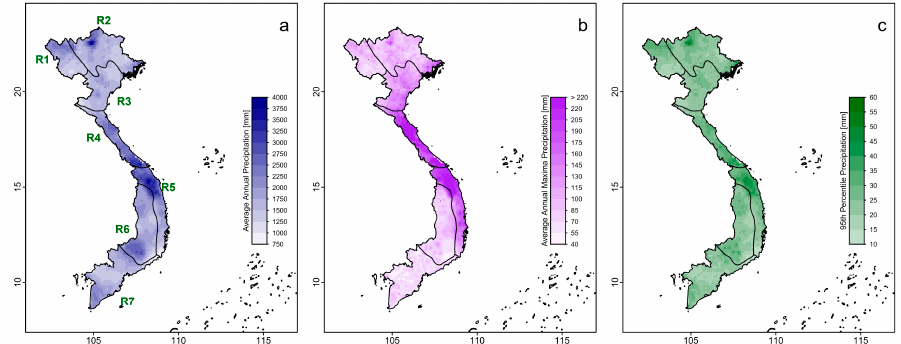
Figure 4. Characteristics of precipitation across Vietnam: ( a ) average annual precipitation, ( b ) average annual maxima precipitation, and ( c ) the 95th percentile threshold. Seven climate regions are also shown as polygons bounded by black lines.